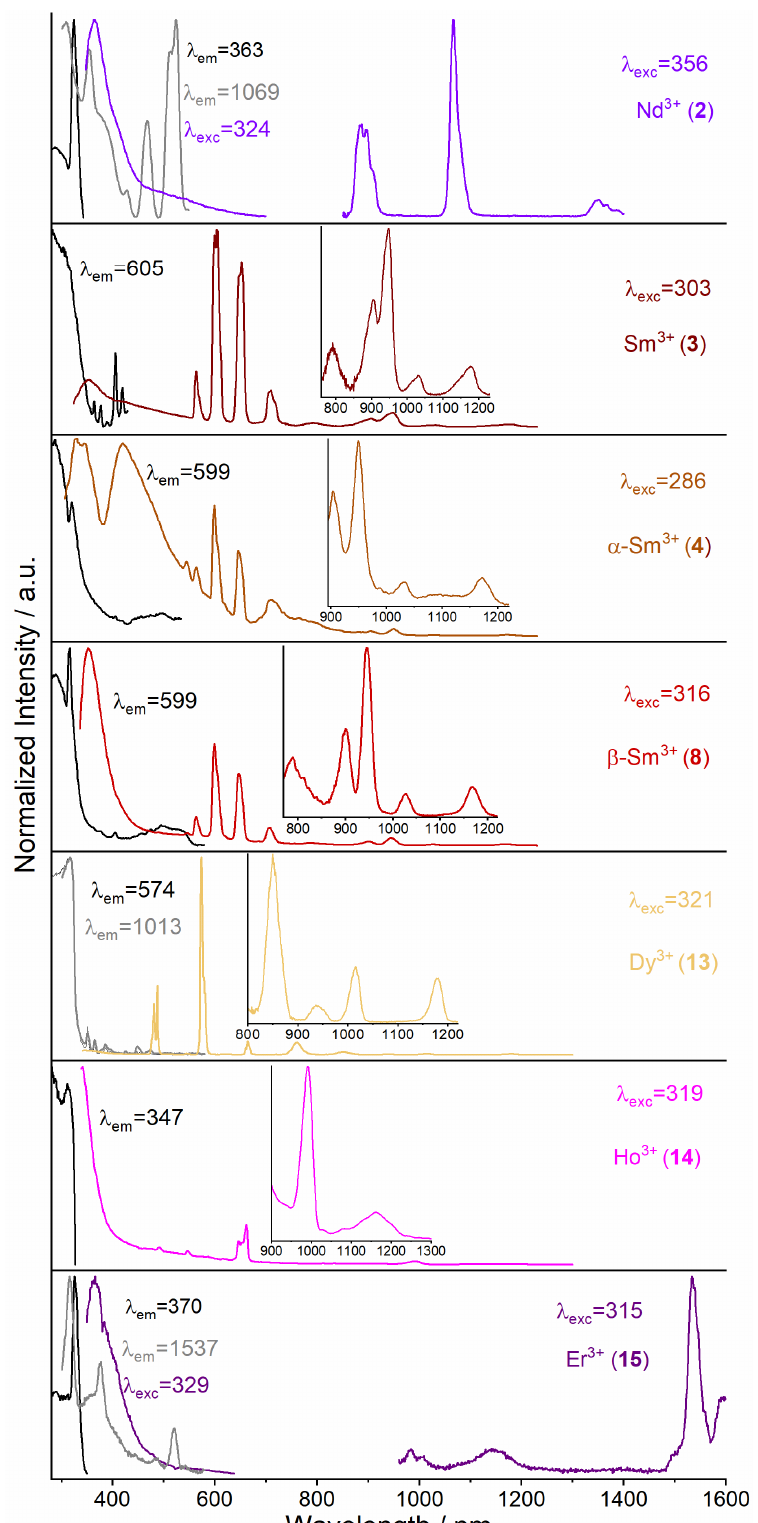
Figure 8. Normalized solid-state excitation (black) and emission spectra (colored) of 1 ∞ [Ln 2 (2– PyPzH) 4 Cl 6 ], Ln = Nd ( 2 ), Sm ( 3 ), α –[Sm 2 (2–PyPzH) 4 Cl 6 ] ( 4 ), β –[Sm 2 (2–PyPzH) 4 Cl 6 ] ( 8 ), and [Ln(2– PyPzH) 2 Cl 3 ], Ln = Dy ( 13 ), Ho ( 14 ), Er ( 15 ) at 77 K. Wavelengths for which the spectra were recorded are given in the legends.